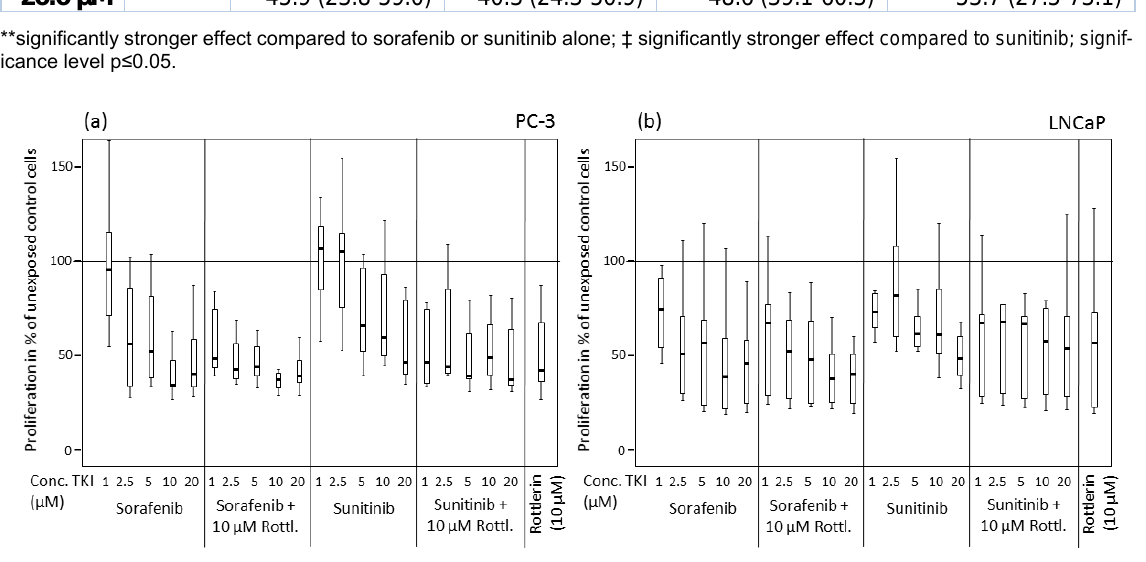
Figure 2: Proliferation of prostate cancer cells exposed to various concentrations of sorafenib and sunitinib with/without rottlerin (10 µM), determined by BrdU incorporation. ( a ) PC-3 cell line; ( b ) LNCaP cell